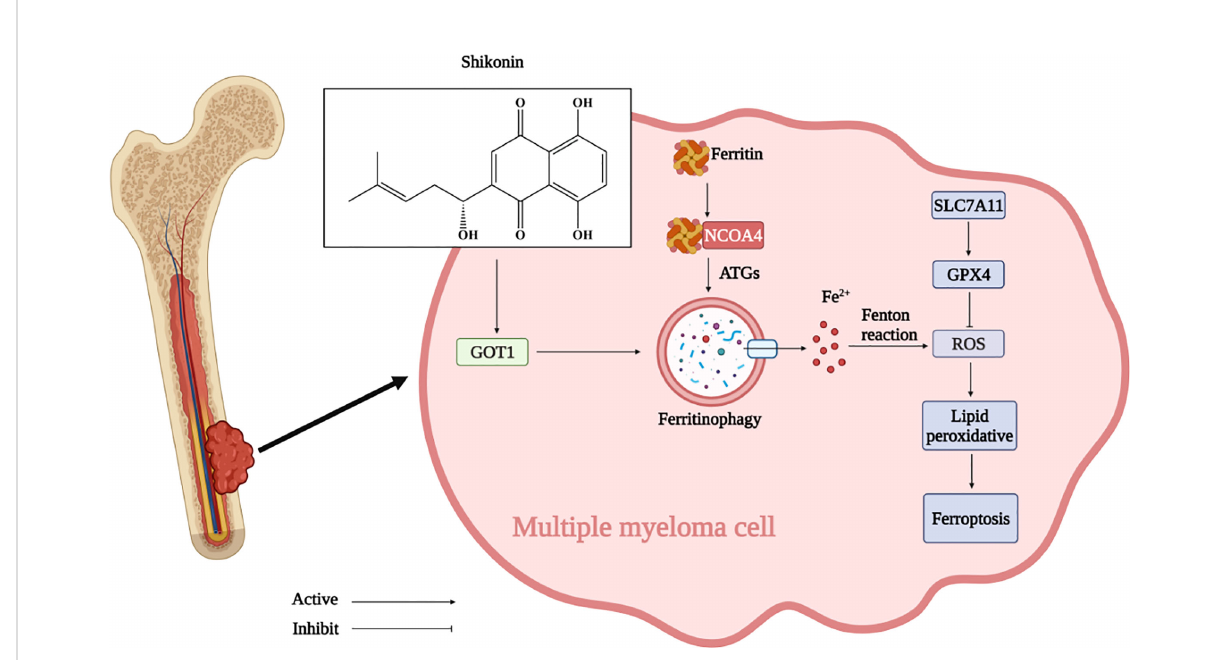
FIGURE 7 SHK inhibited MM development by regulating GOT1 to activate ferritinophagy and further to promote ferroptosis in MM. (Created with